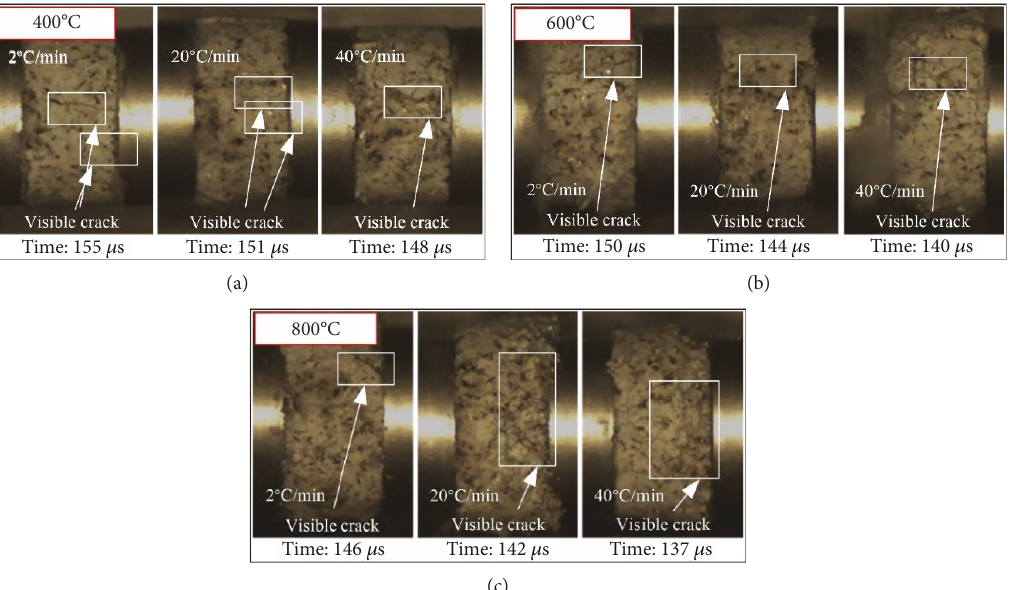
Figure 16: Images obtained by high-speed photography of rocks at various heating rates and temperatures under the impact process: (a) 400 ° C; (b) 600 ° C; (c) 800 °